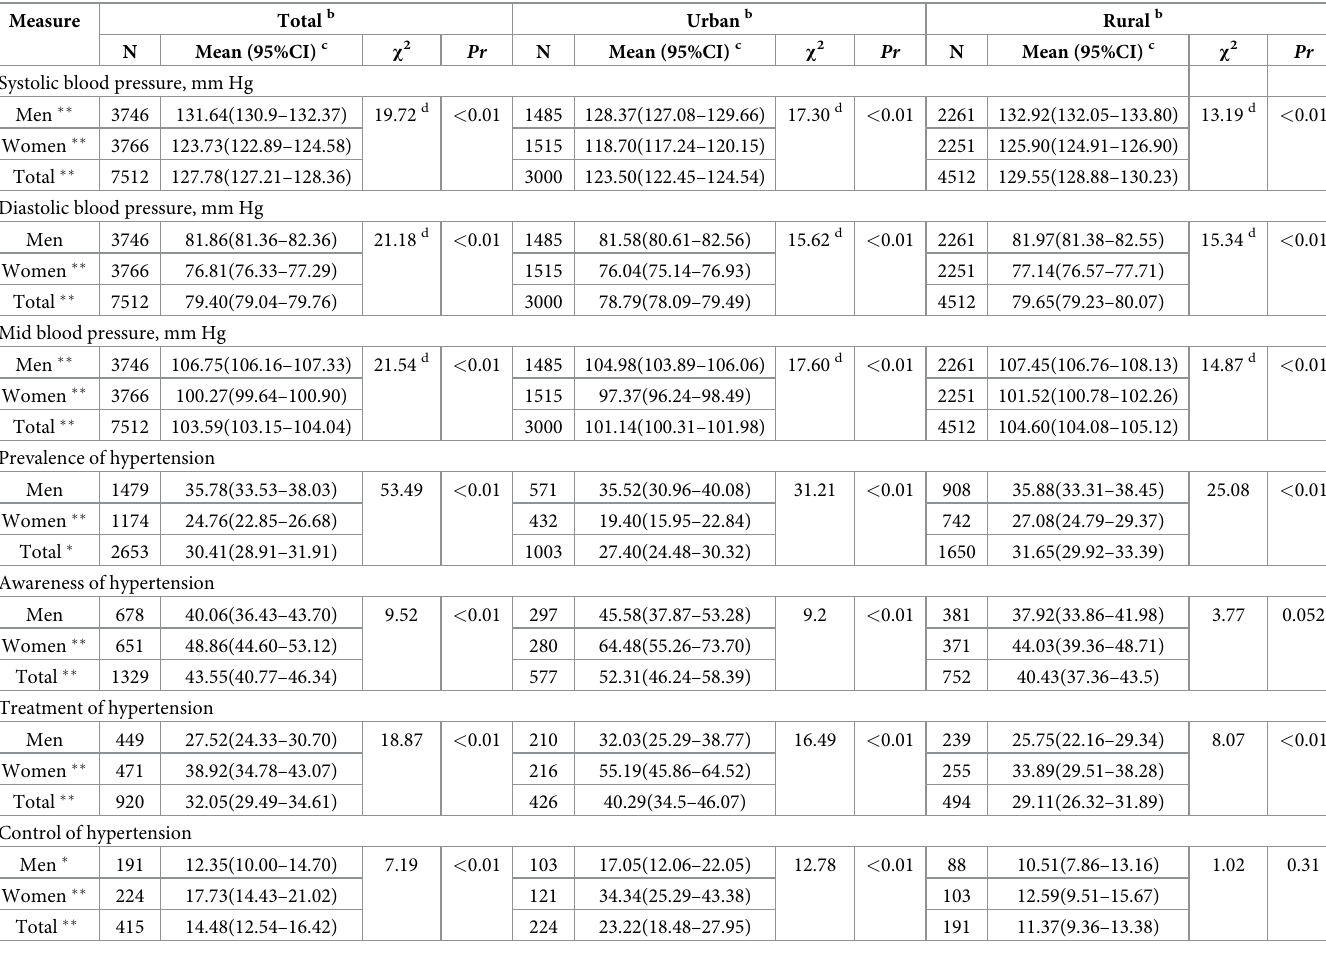
Table 2. Means of SBP, DBP, MDP and prevalence, awareness, treatment, control of hypertension in Zhejiang Province of China in 2017 a .